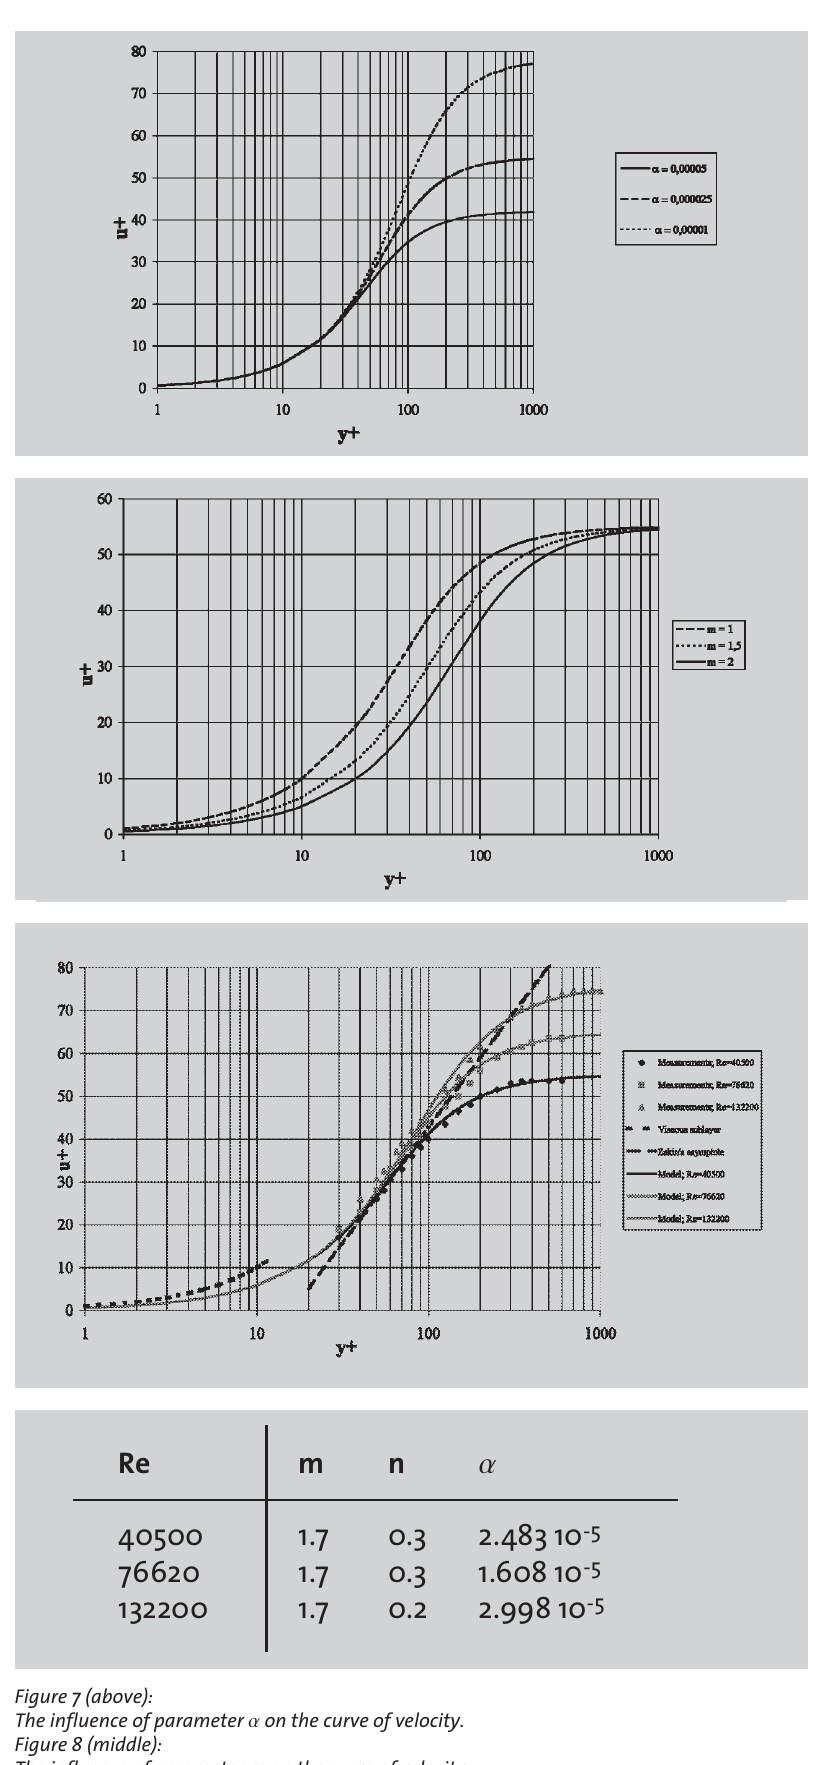
Figure 7 (above): The influence of parameter a on the curve of velocity. Figure 8 (middle): The influence of parameter m on the curve of velocity. Figure 9 (below): Comparision of calculated and measured [24] mean velocity profiles for Habon-G (500 ppm). Table 1 (bottom): The values of parameters for